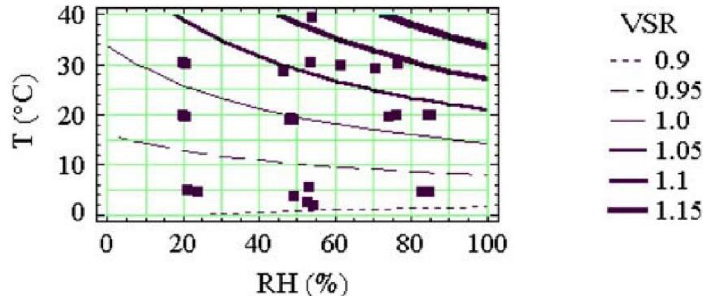
Figure A3. Variability of sampling rate (VSR) as a function of temperature and relative humidity for Palmes PDTs exposed for 24 h in a chamber at a wind speed of 0.54 m s − 1 . VSR values are expressed relative to the sampling rate at T = 20 ◦ C and RH = 50%. Figure reproduced from Plaisance et al. [39] with permission of Elsevier.